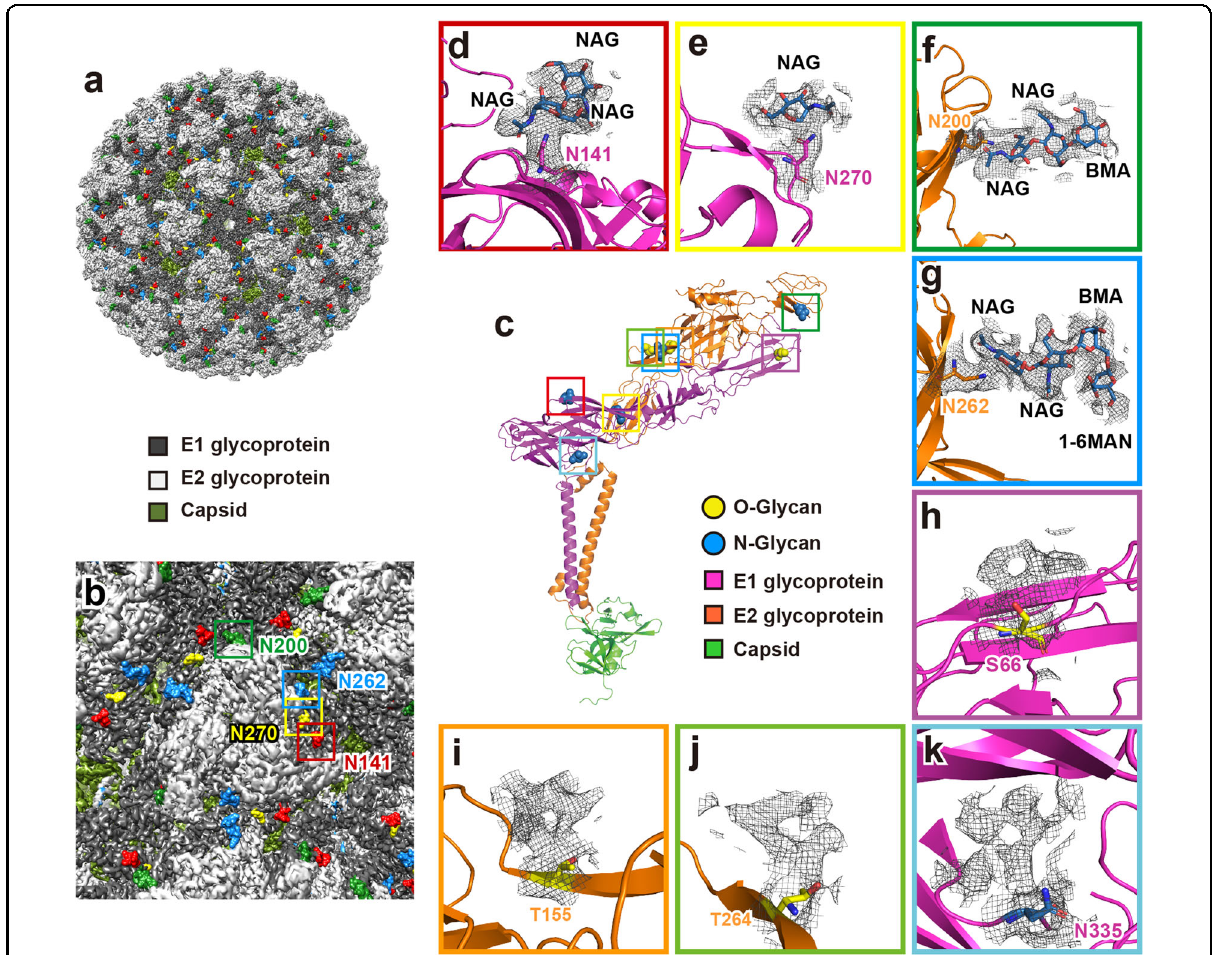
Fig. 5 Atomic models of glycans fi tted in the density maps in the E1 – E2 ectodomain. a External surface of a GETV virion, with glycosylation sites displayed in color (E1 N141 in red, E1 N270 in yellow, E2 N200 in green, and E2 N262 in blue, respectively). b Zoomed-in view of the external surface close to the icosahedral 3-fold vertices; the glycosylation sites are framed and labeled using the same color scheme as shown in panel a . c Glycosylation sites in the atomic model of E1 – E2 – Capsid heterotrimer. d – g Zoomed-in views of N -glycosylation sites with residues shown as sticks (N141 and N270 in E1 are in purple, and N200 and N262 in E2 in orange). Cryo-EM densities attributed to glycans are shown as mesh; the atomic models for the glycans are shown as blue sticks. The names of carbohydrate monomers are labeled. N -Acetyl-glucosamine (NAG) and mannose (BMA: β - D -mannose; 1-6MAN: α